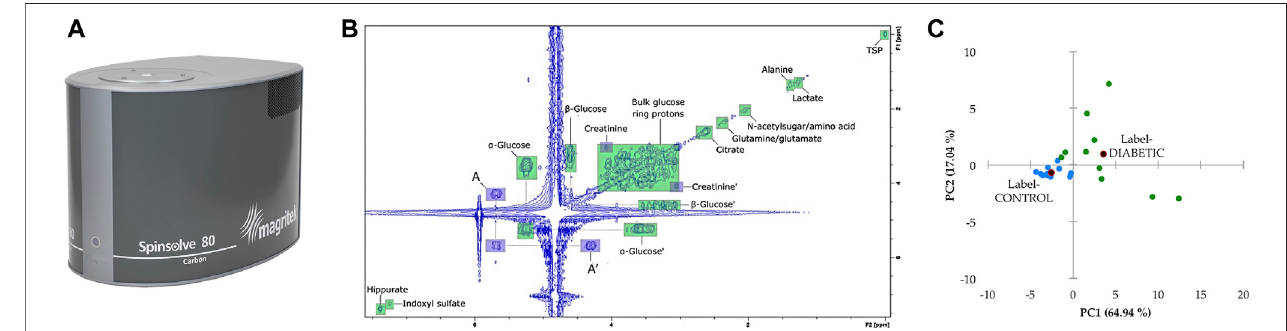
FIGURE 8| Potential ofbenchtop NMR spectroscopy to make NMR metabolomics more accessible in a clinical context. (A) Typical benchtop NMR spectrometer (B) 2D 1 H – 1 HCOSY NMR oftype 2diabetesurinary pro fi le acquired at 60 MHz using abenchtop NMR spectrometer.Creatinineblue squaresrepresent thelong-range connectivitycross-peakfor thismetabolite. Bluesquareslabelled Arepresentunassigned, unusualdoublet resonances arisingfrom ‘ mirroring ’ spectralsignallocatedat δ (cid:1) 5.13 – 5.29 ppm (in thiscase, re fl ecting the α -glucose cross-peak). (C) Principal component analysis(PCA) scoresplot ofPC2 (17.04% oftotal variance) versus PC1 (64.94% of total variance) for a preliminary investigation of distinctions between healthy control and type 2 diabetic cohorts, and also potential sample outliers. Colourcodings: blue, urine samplescollectedfrom healthy controls; green, thosefrom type 2diabetesparticipants. The black points represent scoresplot centroids for the two groups explored. PCA was performed using XLSTAT2014 software, and the dataset was TSP-normalised, generalised logarithmically (glog)-transformed and Pareto-scaled prior to analysis. (A) Courtesy of Magritek GmbH. (B) Reproduced from (Leenders et al., 2020) under Creative Commons Attribution 4.0 International License. (C) Reproduced from (Percival et al., 2018) under Creative Commons Attribution 4.0 International